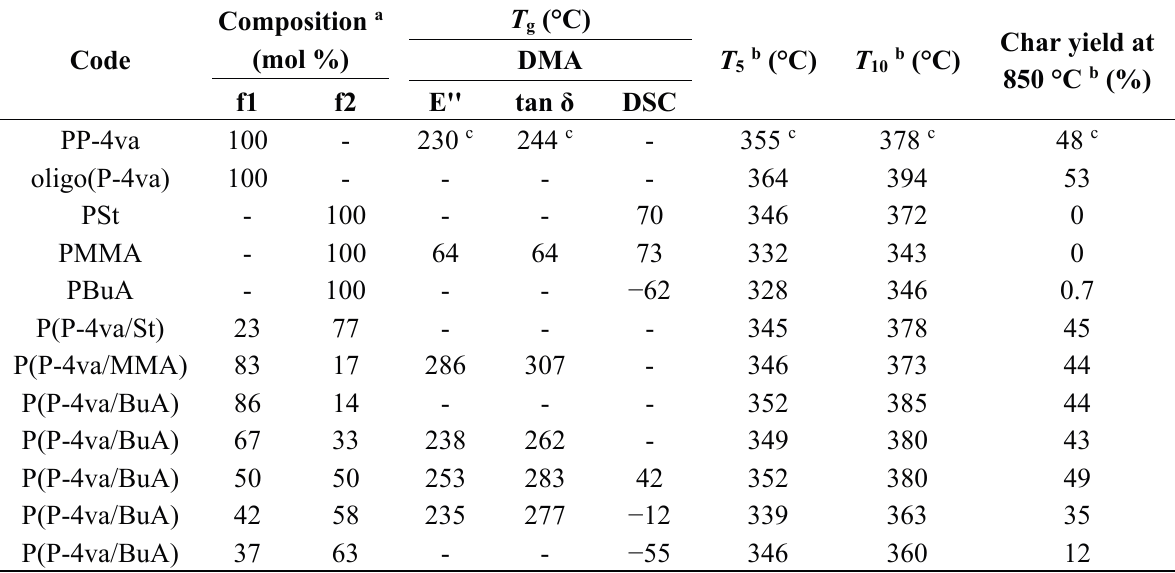
Figure 11. Viscoelastic properties of PP-4va ( ■ ), and P(P-4va/MMA) ( □ ). Table 2. Thermal properties of the cured